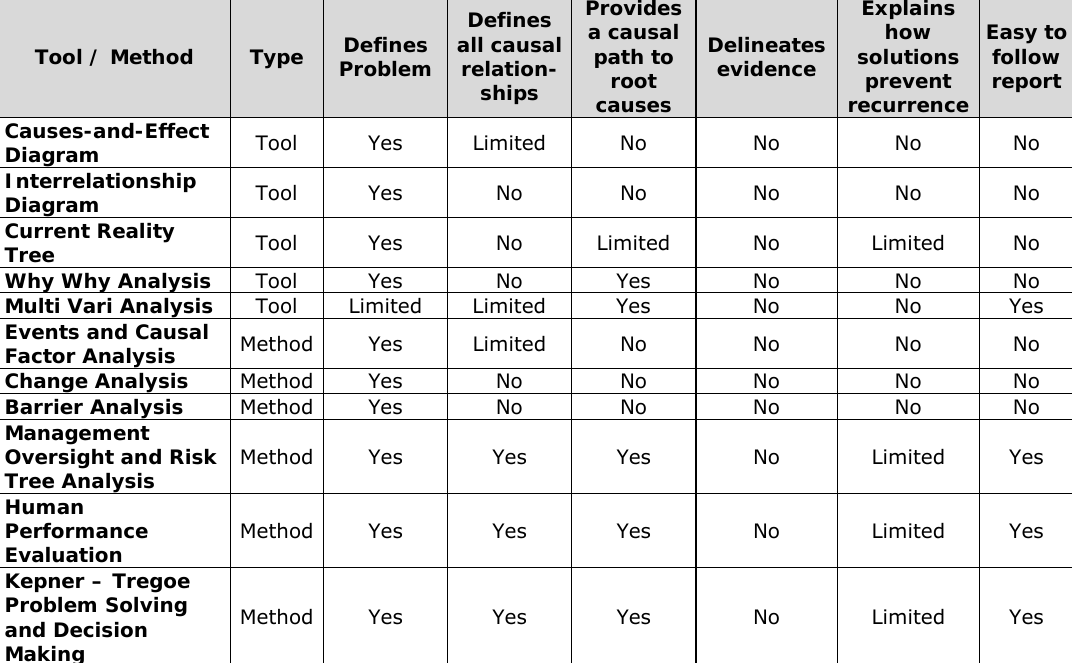
Table 1. “Comparison of selected RCA tools and RCA